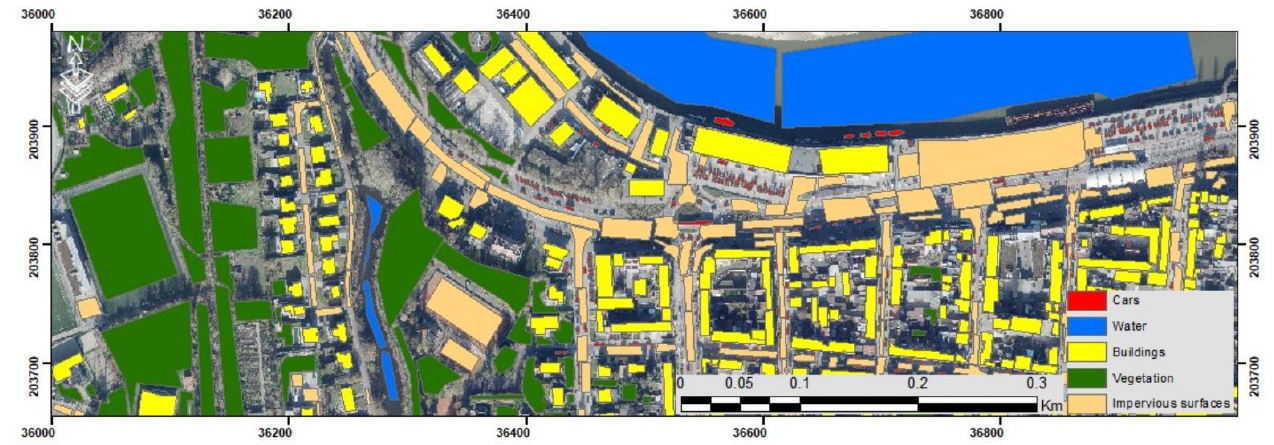
Figure 1. Location of datasets.